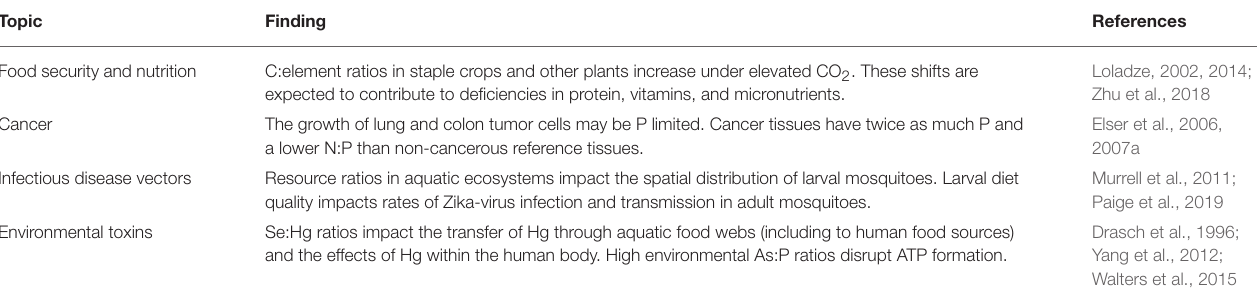
TABLE 1 | Examples of prior research on ecological stoichiometry in a human health context.